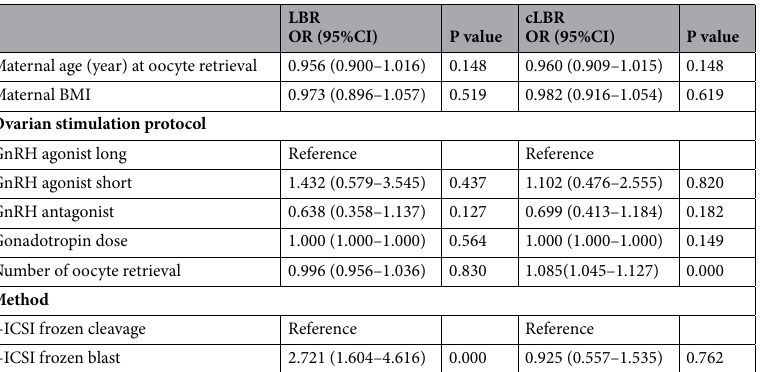
r-ICSI frozen cleavage (N = 161)